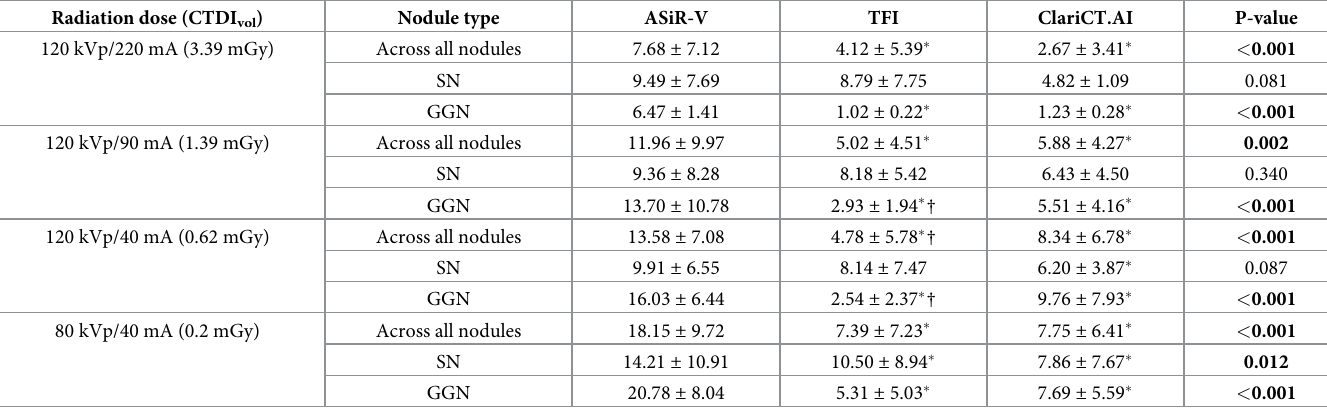
Table 3. Absolute percentage measurement error according to nodule type. Radiation dose (CTDI vol